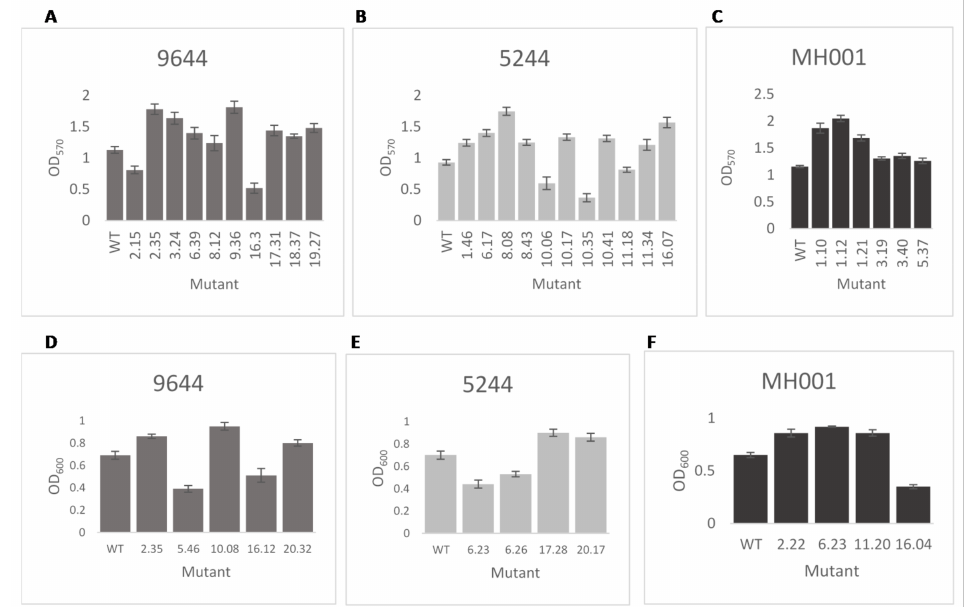
Figure 3. Selected Pseudomonas syringae transposon disruption mutants in biofilm attachment assay and in vitro growth rate. Transposon mutants and wild-type strain (WT) were cultured static in 10 mL broths. After seven days, crystal violet was used to measure (OD 570 ) the attachment of the cells to the culture vessel surface ( A – C ). Differences in in vitro growth were analysed after 8 h growth in LB broth ( D – F ). ( A , D ) P. syringae pv. syringae 9644; ( B , E ) P. syringae pv. morsprunorum R1 5244; ( C , F ) P. syringae pv. morsprunorum R2 MH001. The mutants displayed show a statistically significant difference to their respective WT strain determined, p < 0.05 as assessed by Student’s t -test. Error bars represent the standard error of the mean of three biological